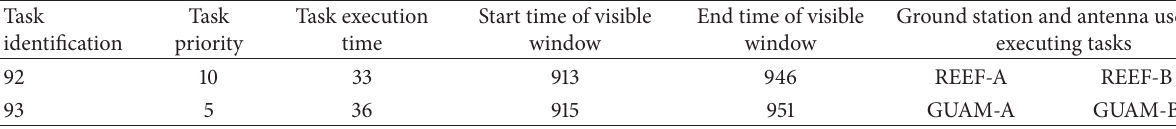
Table 1: The Actual Validation Data Format.